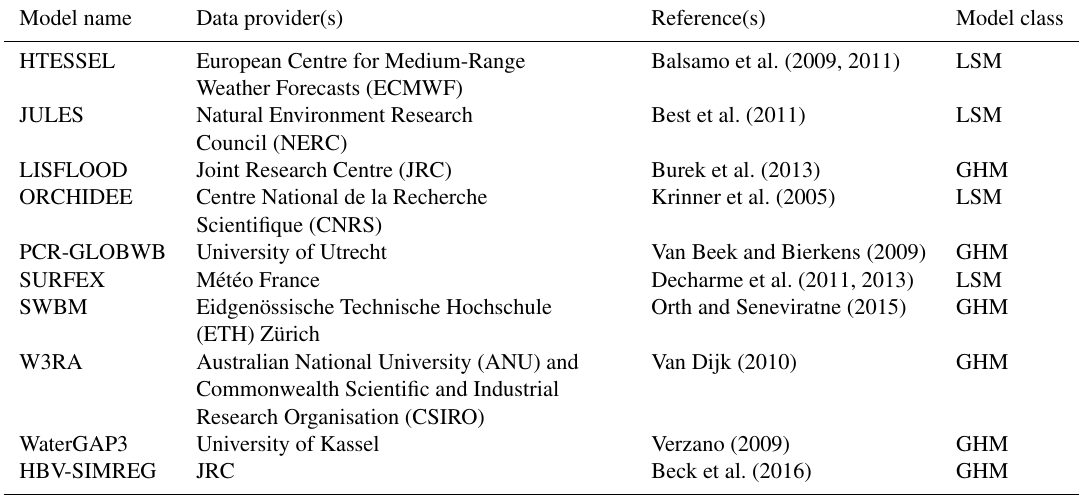
Table 2. Overview of the hydrological models considered in this study. For definitions of the model name acronyms, see Schellekens et al. (2016). Definitions of model-class acronyms: GHM, global hydrological model; and LSM, land surface model.